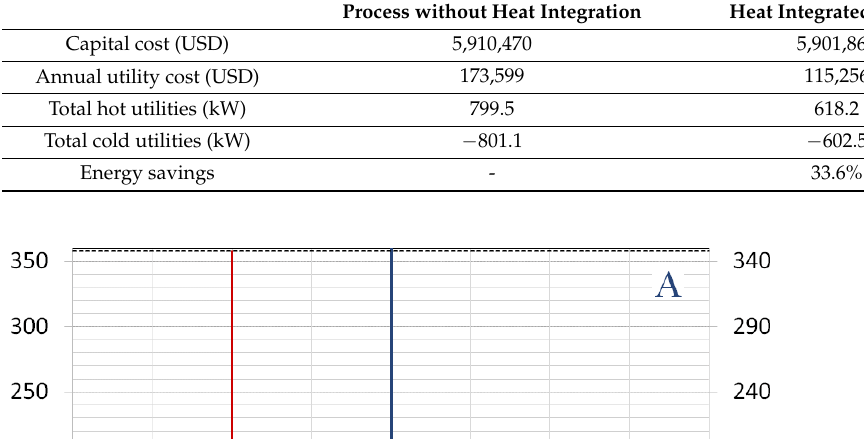
Figure 5. Heat integrated process flowsheet for the production of high purity biodiesel. Table 5. Total costs and utilities required in the biodiesel production process.